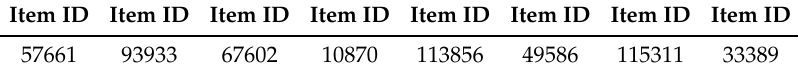
Table 6. Eight deleted target item